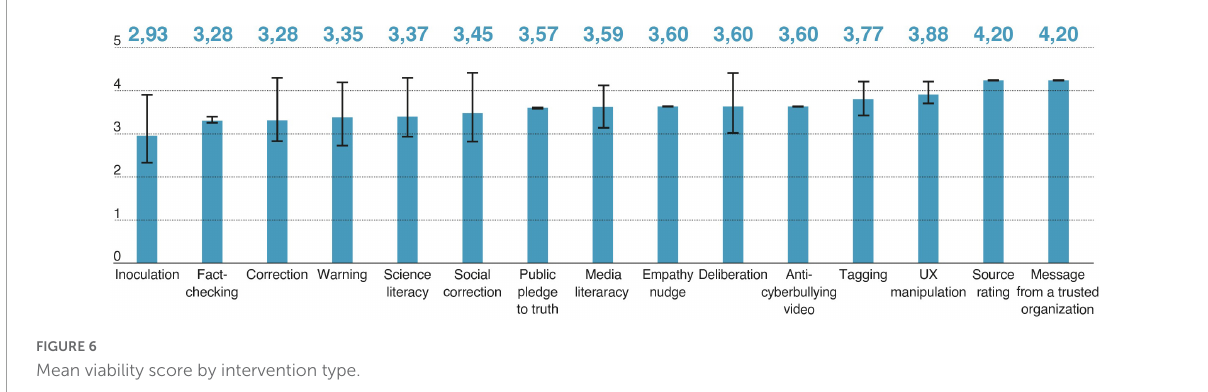
FIGURE6 Mean viability score by intervention